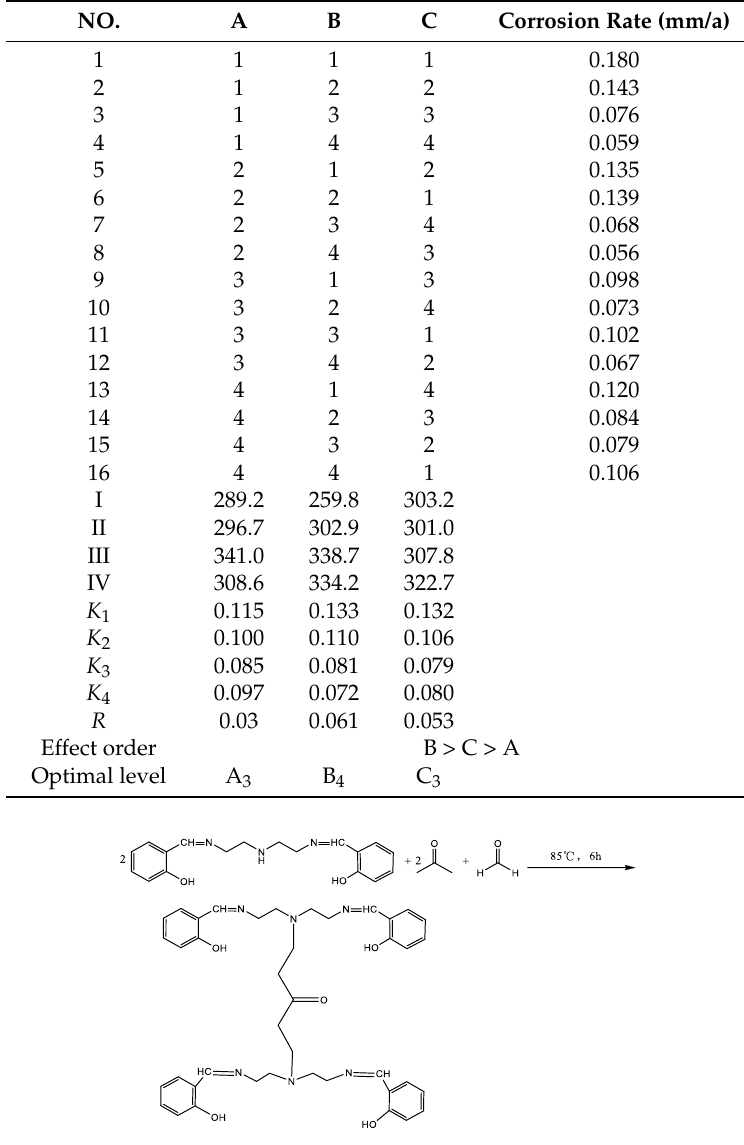
Table 2. Orthogonal experimental